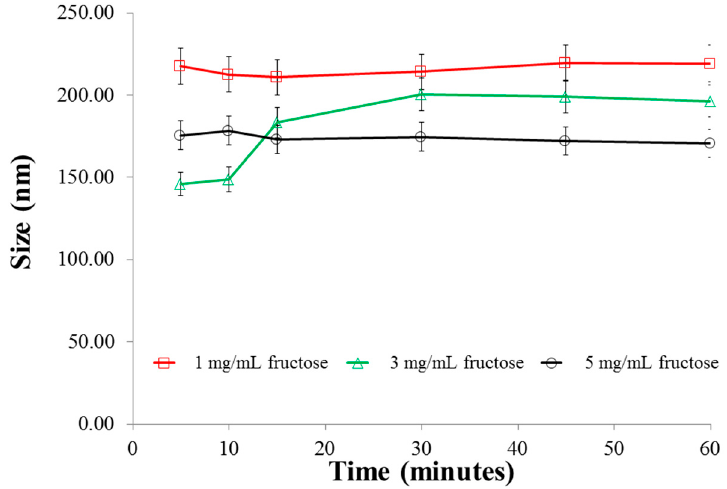
Figure 6. Size changes of the nanoparticles in various concentrations of fructose as a function of time.